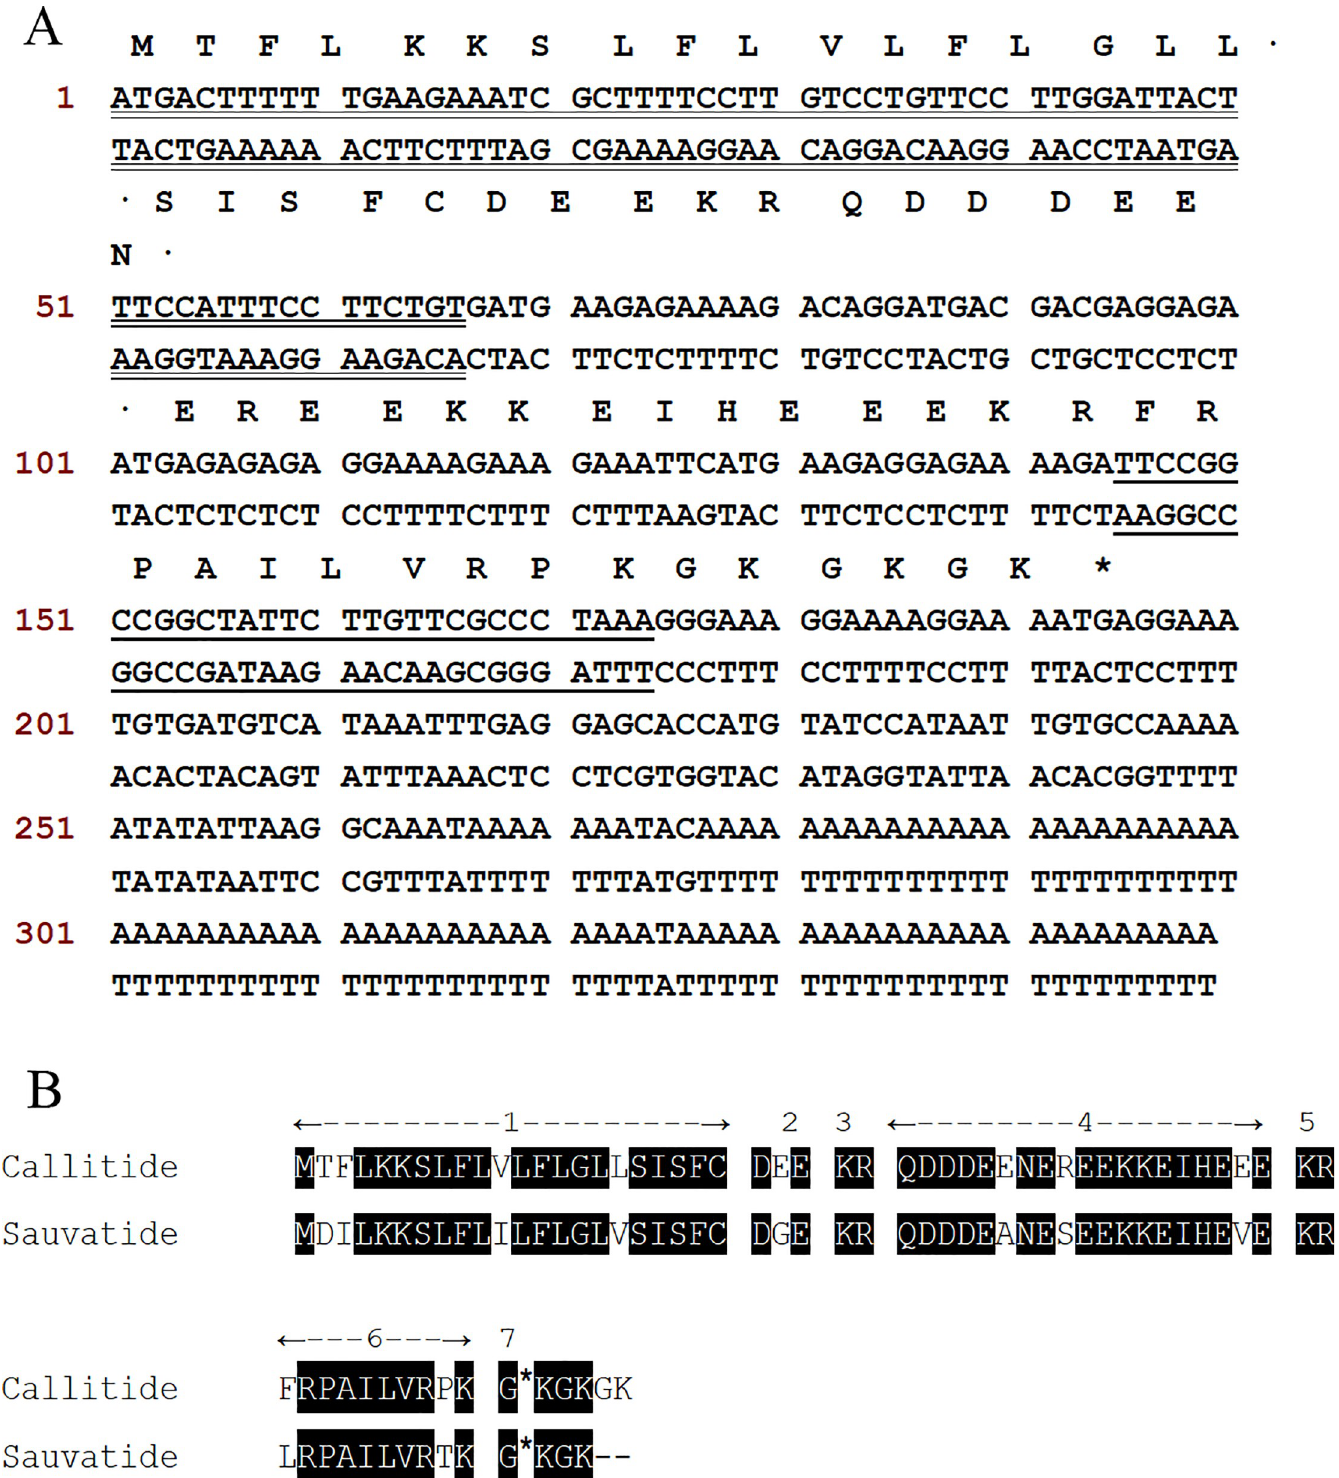
Fig 1. Nucleotide sequence of callitide. (A) Nucleotide and translated amino acid sequence of cloned callitide biosynthetic precursor-encoding cDNA. The putative signal peptide is double-underlined, and the mature callitide sequence is single-underlined. The stop codon is indicated with an asterisk; (B) Alignment comparison of callitide and sauvatide precursor. (1) Putative signal peptide. (2) Acidic spacer peptide-1. (3/5) Propeptide convertase processing sites. (4) Acidic spacer peptide-2. (6) Mature decapeptide. (7) C-terminal processing site with glycyl (G) residue amide donor indicated with an asterisk.